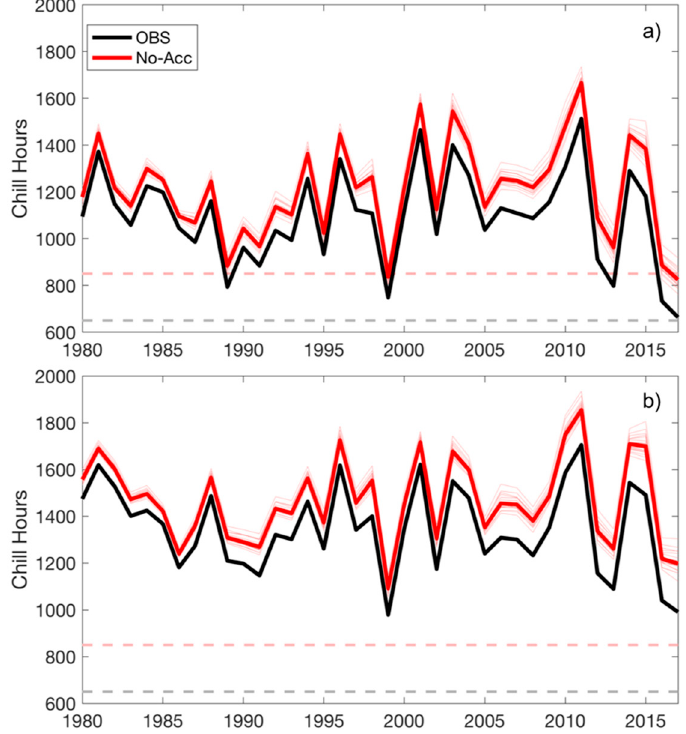
Figure 3. Time series of 1981–2017 chill accumulation for ( a ) the Georgia peach-growing region, and ( b ) the South Carolina peach-growing region. The observed data (OBS) are shown in black, while modeled chill accumulation estimates excluding the influence of anthropogenic climate change (No-Acc) are shown in red, with lighter red lines indicating individual models and the heavy red line indicating the 23-model median. The light pink dashed line indicates the chill requirement for a high-chill peach cultivar and the dashed grey line indicates the chill requirement for a moderate-chill peach cultivar.